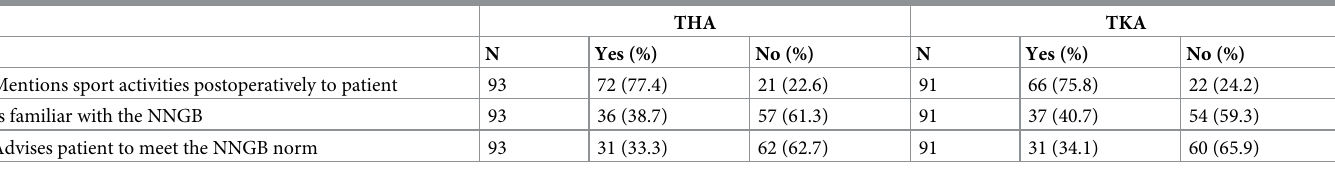
Table 3. NNGB and sport activities after THA and